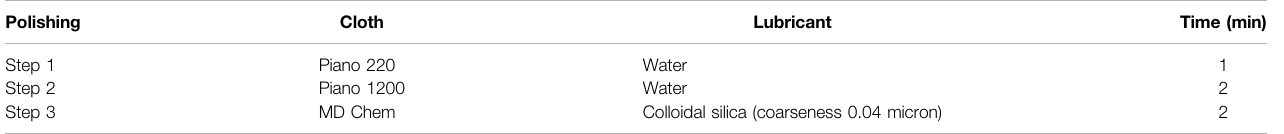
TABLE 3 | Steps involved in polishing for nanoindentation.